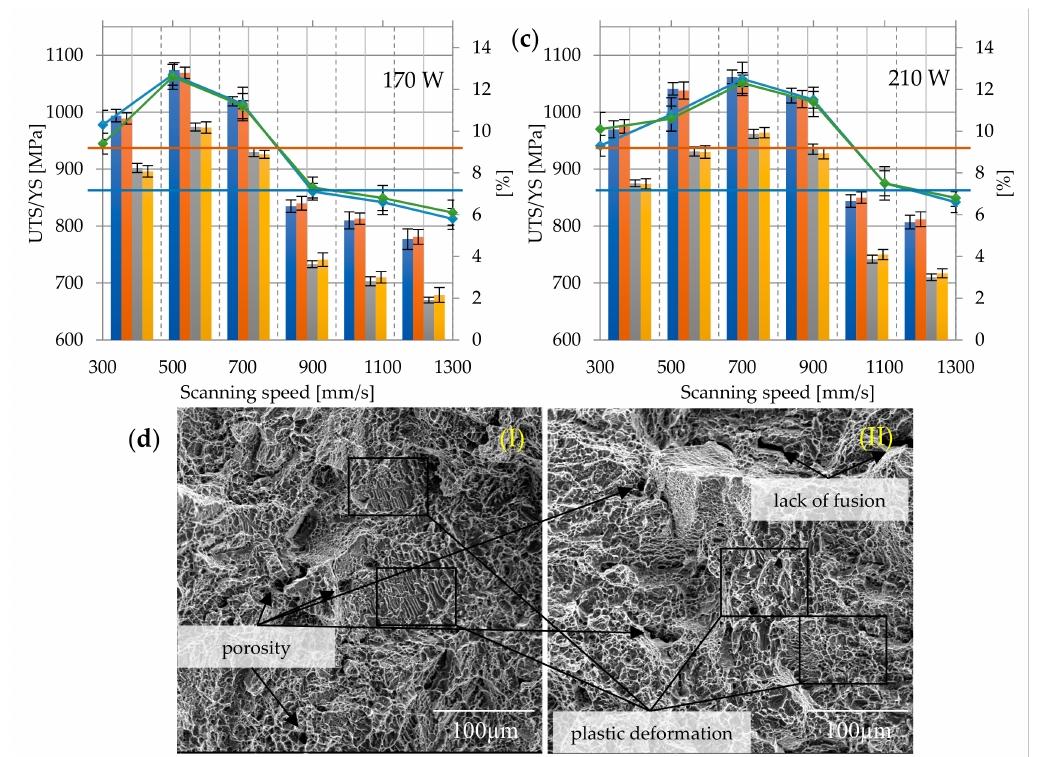
Figure 9. Strength parameters of samples heat treated at 850 ◦ C with di ff erent laser speeds and powers: ( a ) 130 W, ( b ) 170 W, ( c ) 210 W, and ( d ) fracture surface: (I) 130 W, 300 mm / s, ZX; (II) 130 W, 300 mm / s, XZ; 900 × ; Rm min and Re min for Ti6Al4V in accordance with ASTM F